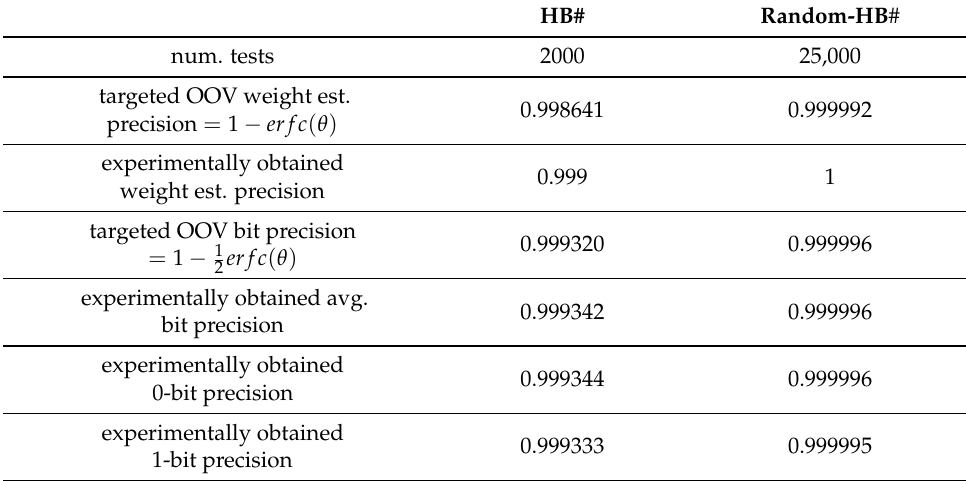
HB# Random-HB # 0.998641 0.999992 0.999 1 0.999320 0.999342